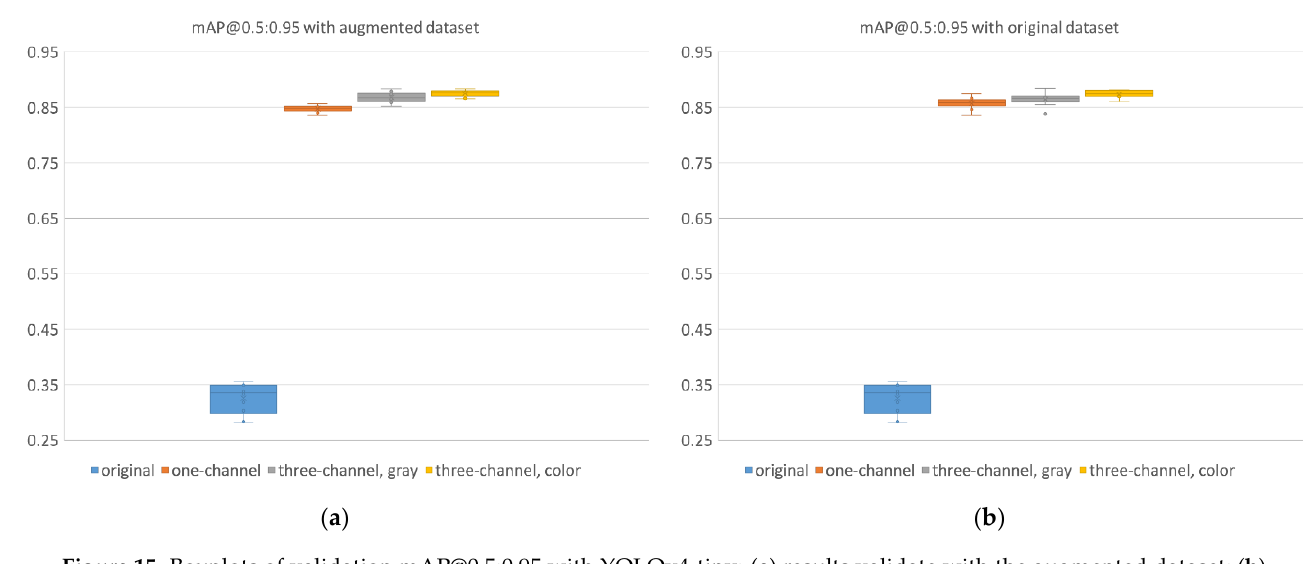
Figure 15. Boxplots of validation mAP@0.5:0.95 with YOLOv4-tiny: ( a ) results validate with the augmented dataset; ( b ) results validate with the original dataset.